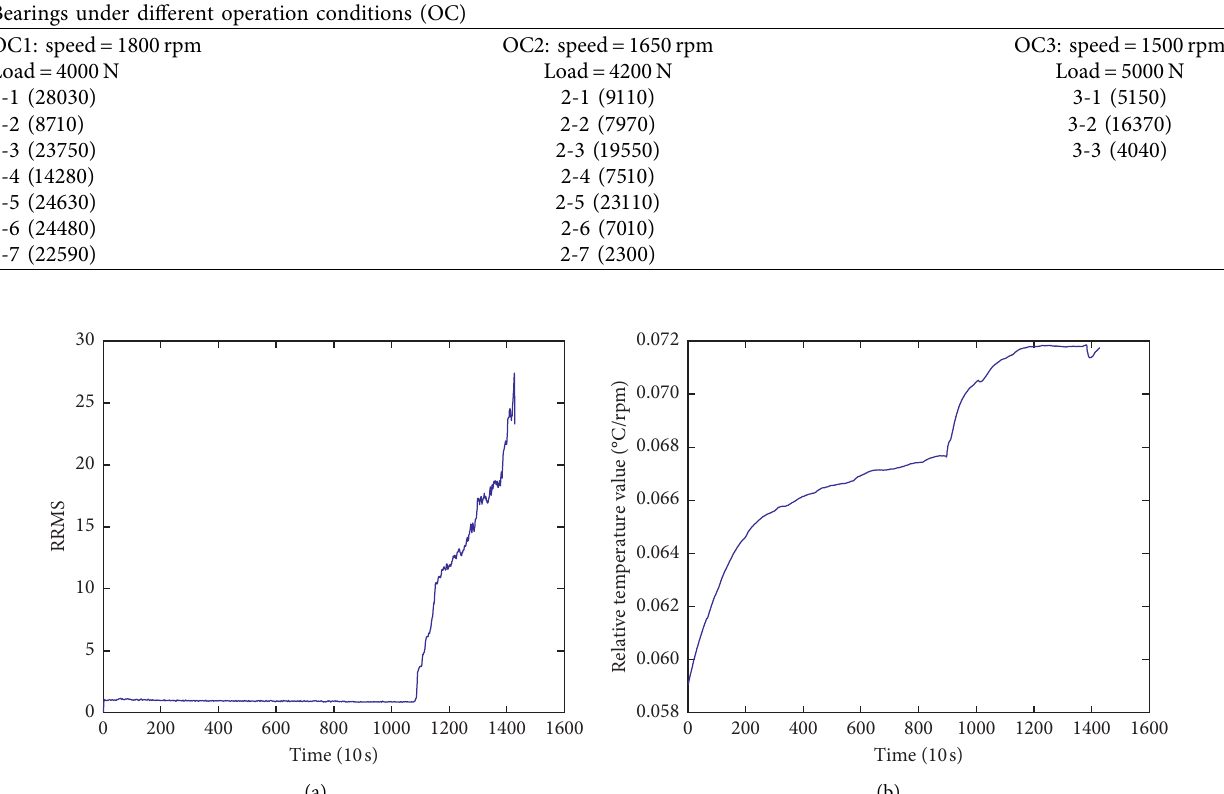
Figure 5: Vibration and temperature features of bearing 4 from OC1. (a) Vibration features, (b) temperature